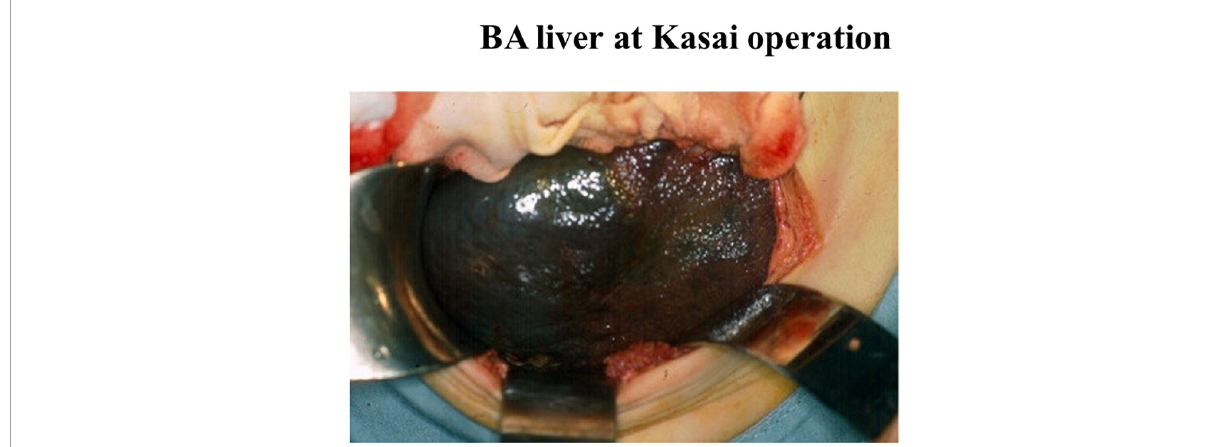
FIGURE1 The liver exteriorized out of the upper abdominal cavity at the time of Kasai portoenterostomy. Note the nodularity confined to the surface of a well-demarcated left lateral segment. Courtesy of Dr. Riccardo Superina, Feinberg School of Medicine, Northwestern